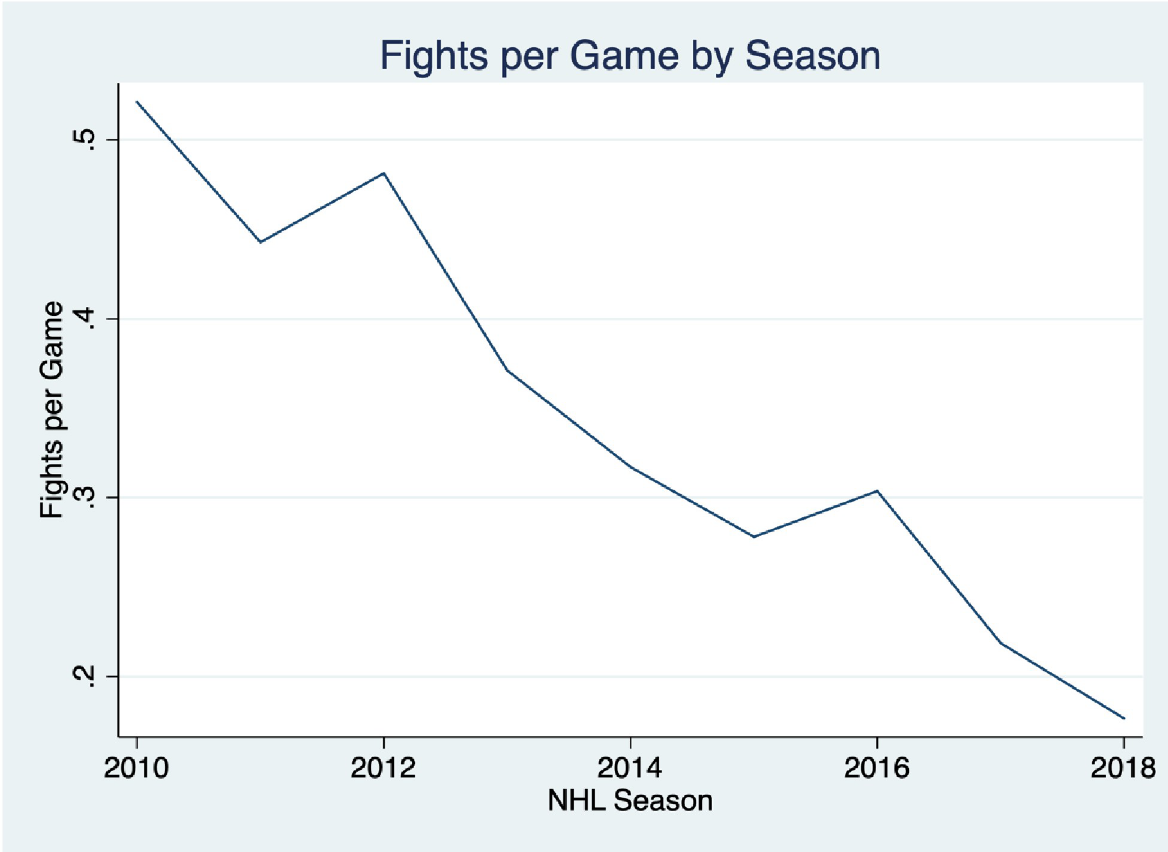
Fig 1. NHL fights per game by season 2010–2019. This figure shows the average number of regular season fights per game for each season between the 2010–11 and 2018–19